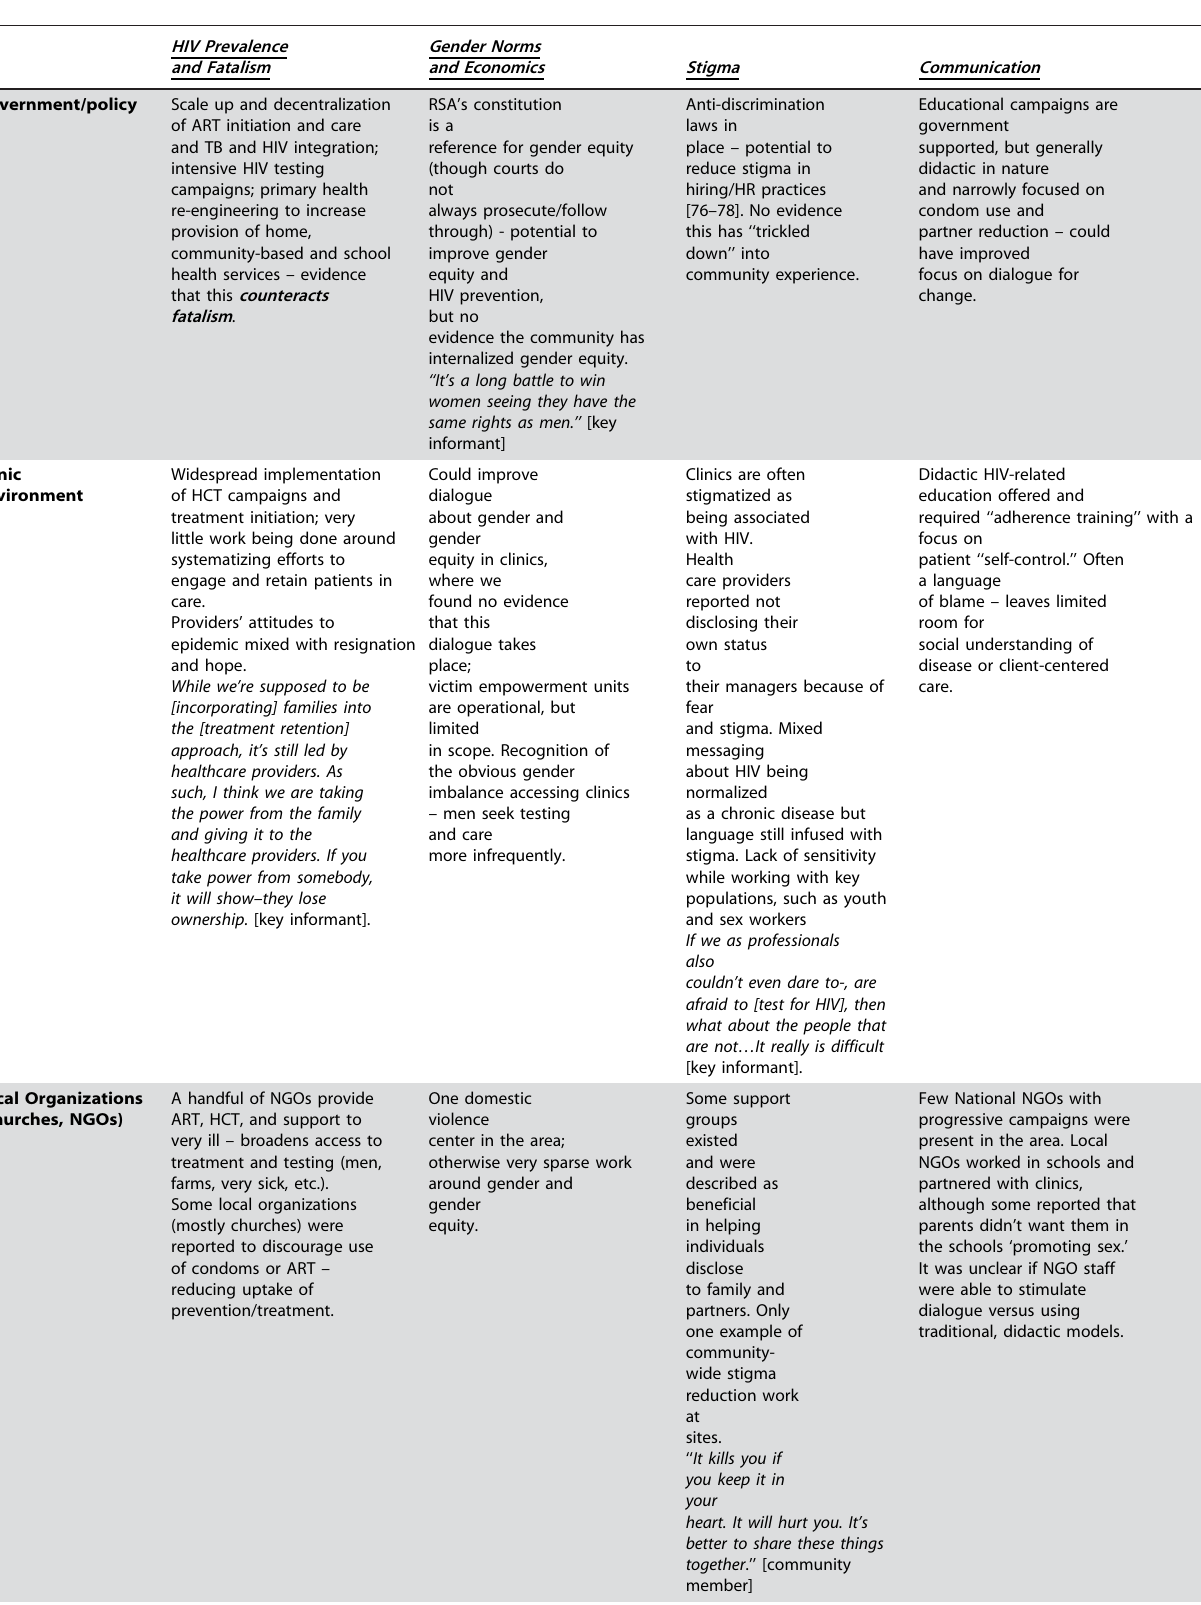
Table 3. Current responses at multiple levels of intervention to address the social contextual factors impacting HIV